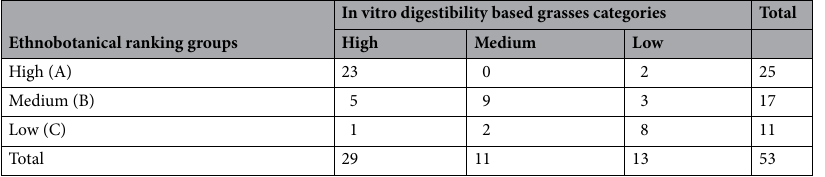
Ethnobotanical ranking